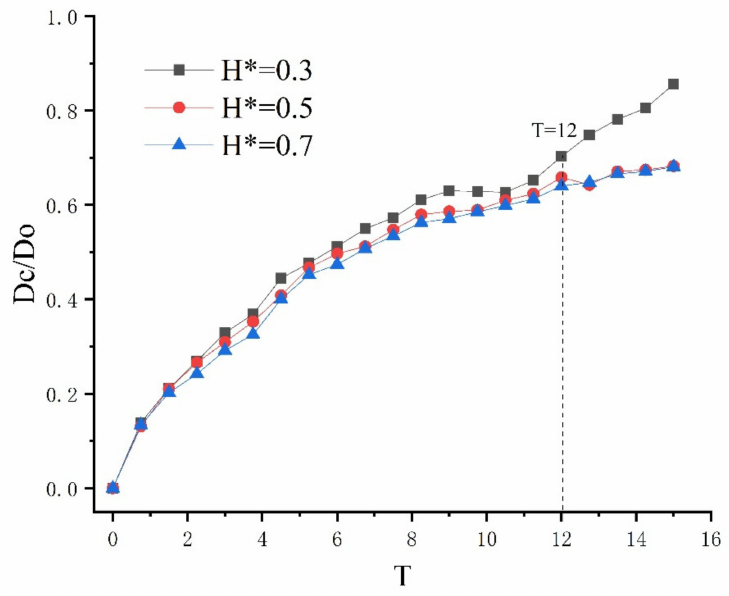
Figure 12. The dimensionless crown rim diameter changing with dimensionless time under different